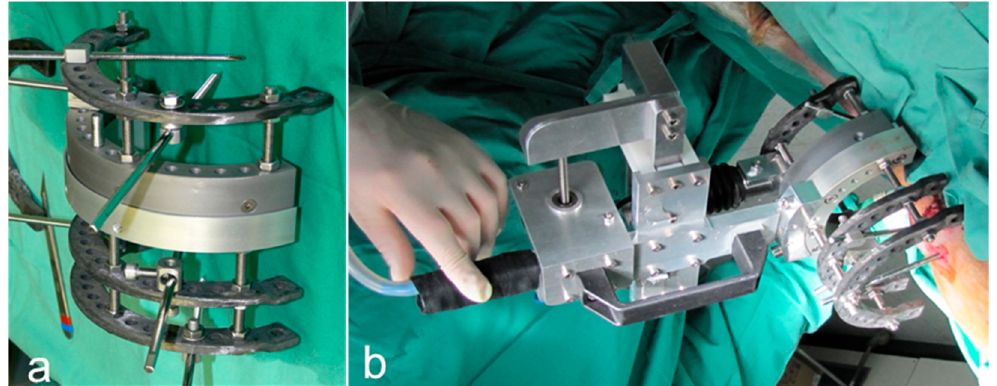
Figure 9. ( a ) Conventional external fixateur with a modified double half-ring allowing free